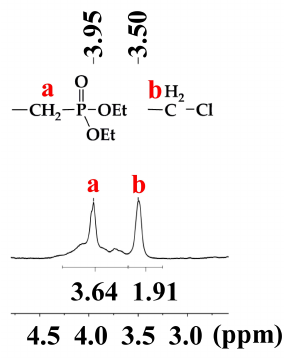
Figure 5. 1 H-NMR of polymer 3 and relative assignment of the peaks. The conversion of the chloropropyl groups into phosphonate-propyl groups was determined according to the integral ratio (Figure